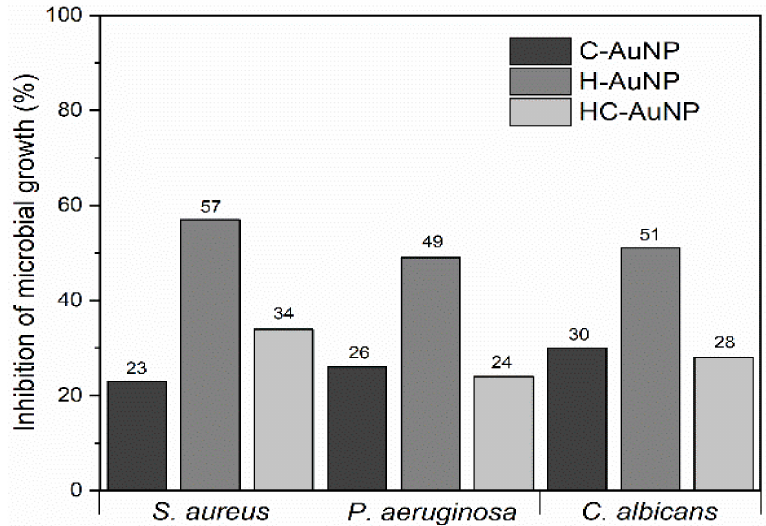
Figure 7. Inhibition of microbial growth after incubation with peptides-conjugated